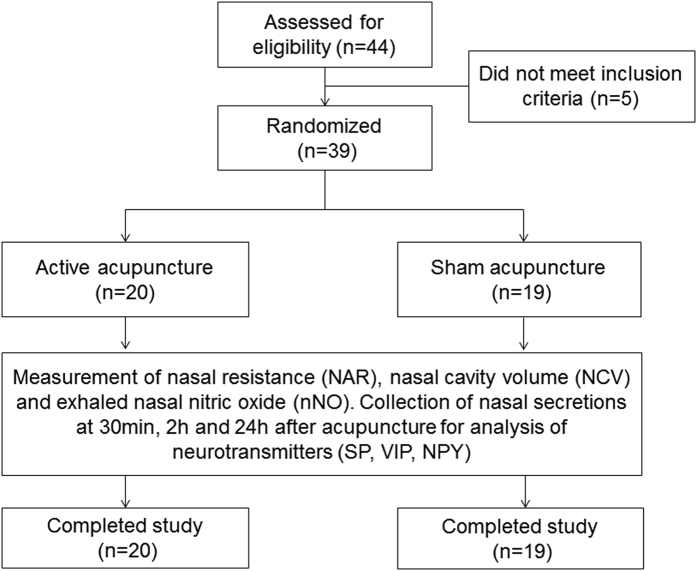
Study flow-chart.